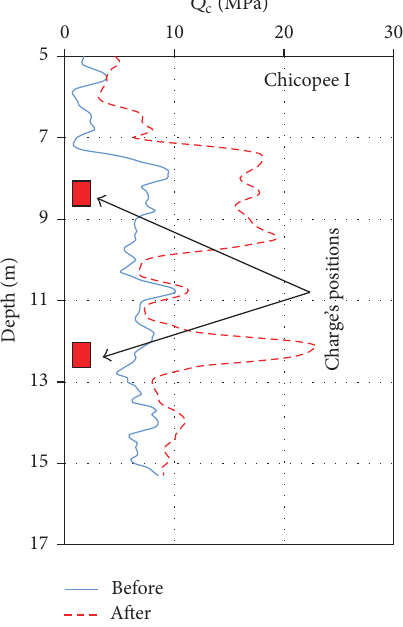
Figure 6: CPT results before and after blast densification in Chicopee project I (CPT data: [24]).